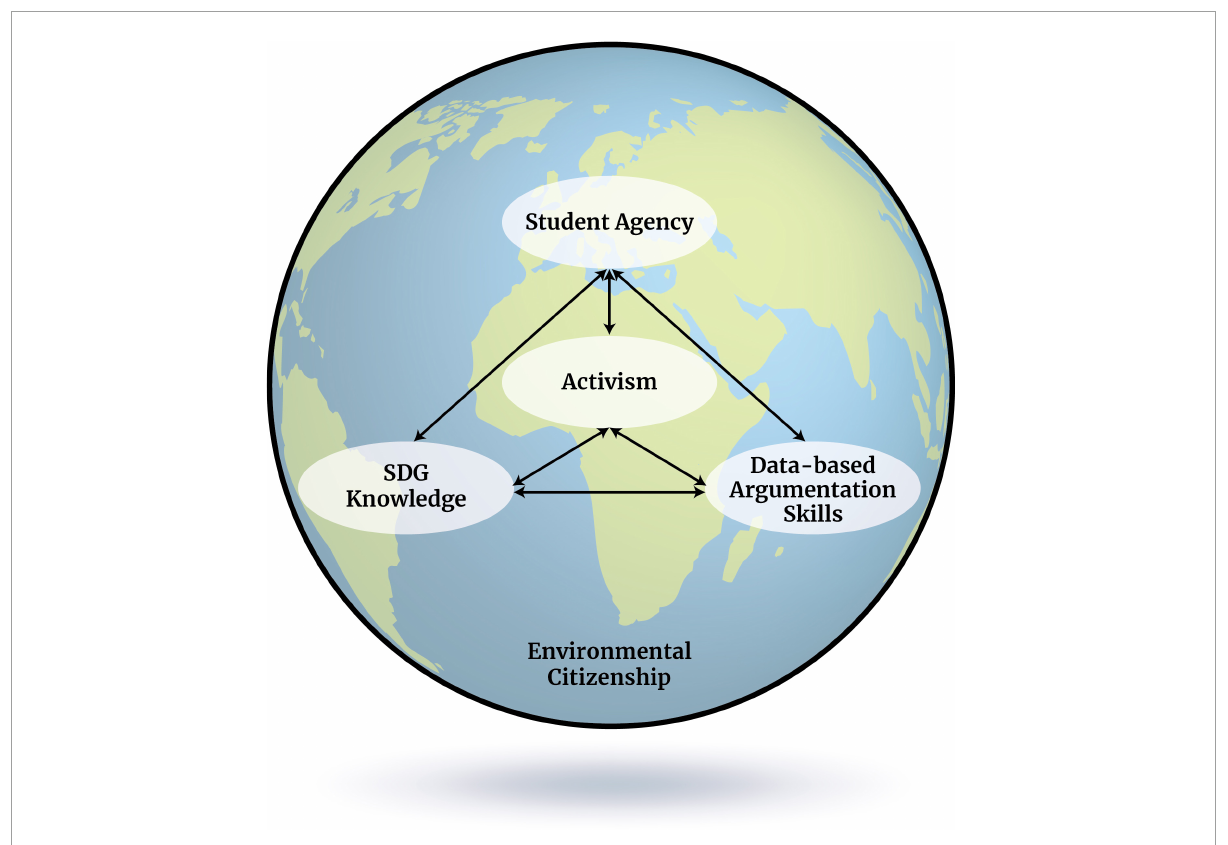
FIGURE4 A model to develop data-based student agency on sustainability issues.